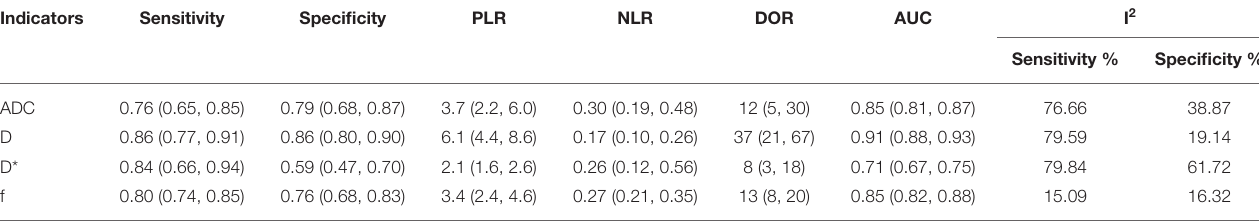
TABLE 4 | Pooled estimates and heterogeneity measures for the ADC, D, D * and f values. Indicators Sensitivity Specificity